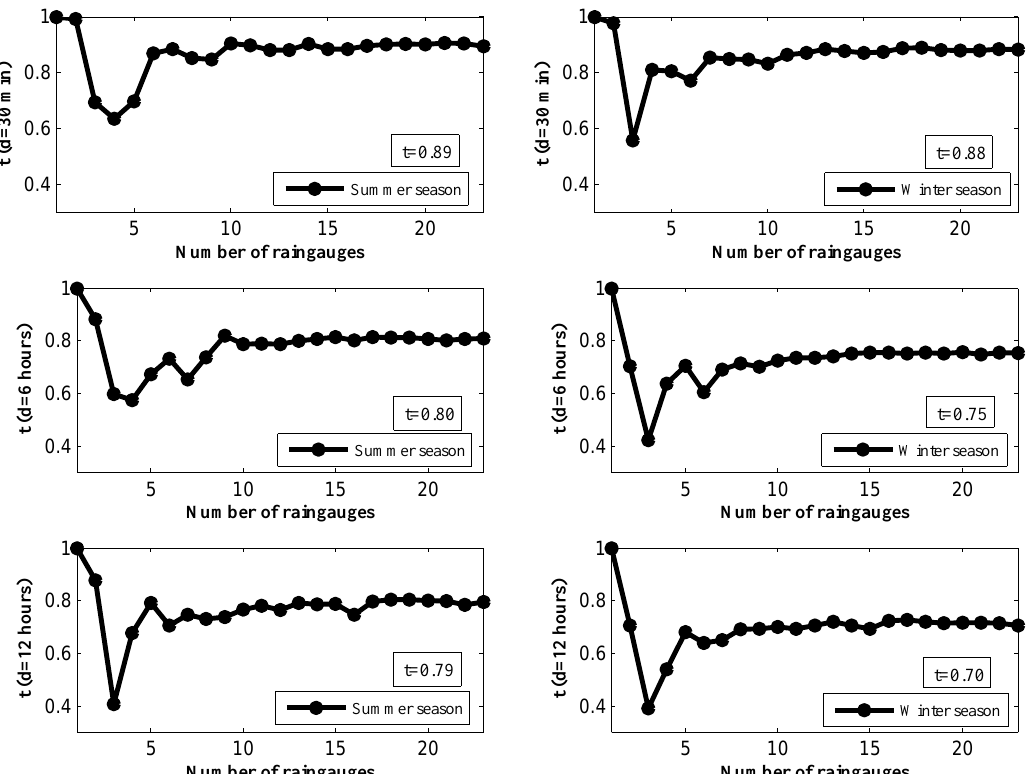
Fig. 2. Coefficient of nontransferred information for sampling time intervals of d = 30min, 6 and 12h for the summer (left) and winter (right) seasons in Rome. The maximum content of non-redundant information is quoted in the box for each sampling time. This result is the value assumed by t , corresponding to the last raingauge added to the network. The same values are presented on a semi-log scale in Fig. 5 for each